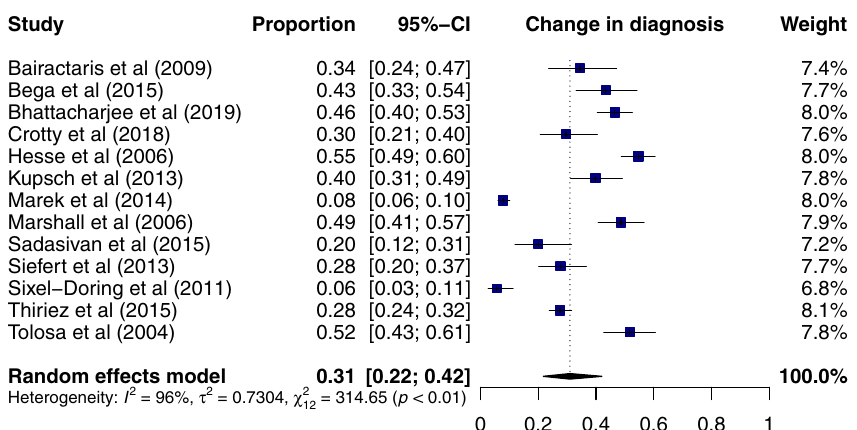
Fig. 2 Forest plot of the meta-analysis of studies reporting change in diagnosis with DaTscan using a random-effects model. The studies are ordered